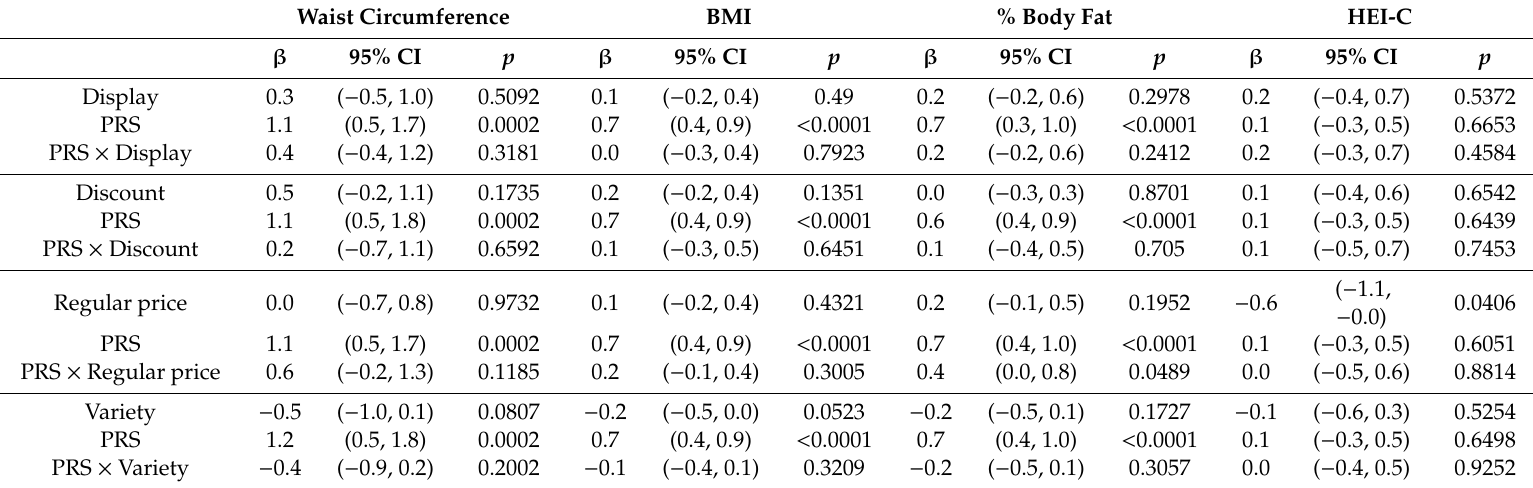
Table 8. Main and interaction e ff ects of genetic risk score and retail food environment scores on adiposity-related outcomes among females ( n =